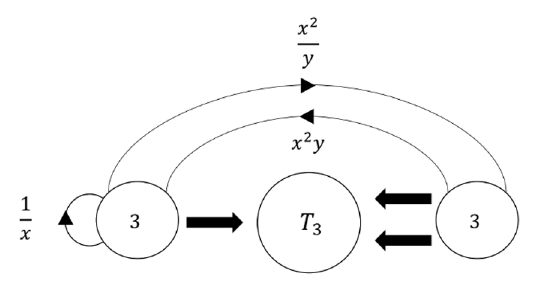
Figure 5 . The model proposed to be dual to the N = 3 SCFT with moduli space ( C 3 ) 3 =G (3 ; 3 ; 3) with the charges under the gobal symmetries written in terms of fugacities. We also note that U(1) x acts on the T 3 theory, where it acts as U(1) g